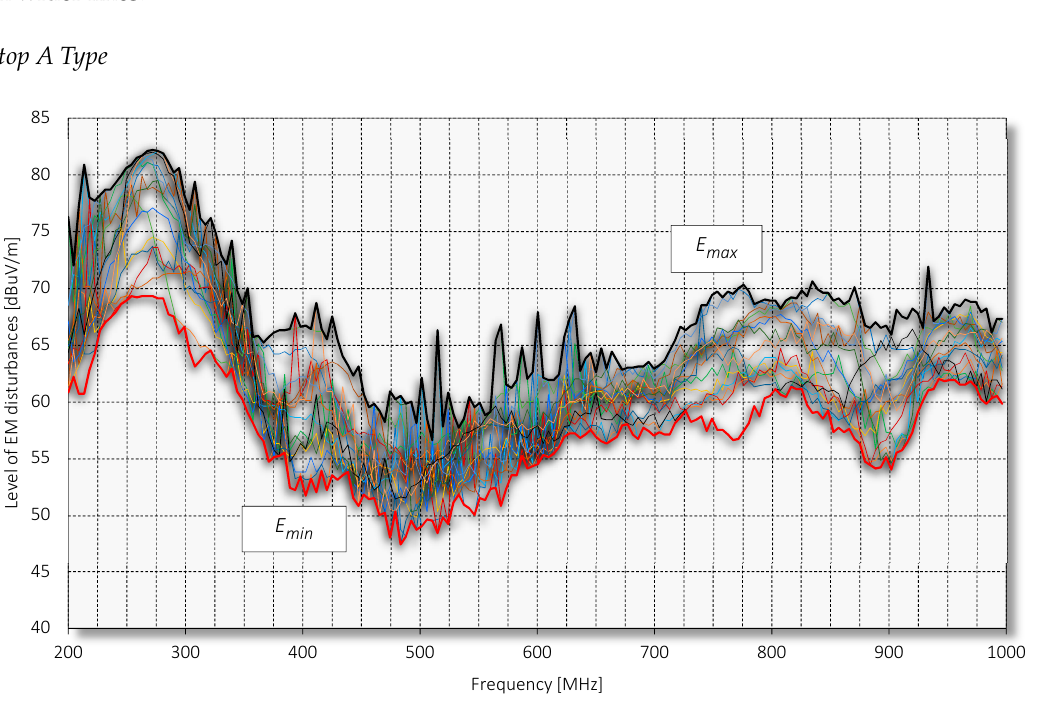
Figure 5. Levels of electromagnetic disturbances (valuable emissions, 15 measured devices of the same type) measured for laptop A in the range of frequencies from 200 MHz to 1 GHz, BW = 50 MHz, measurement distance: 1 m.